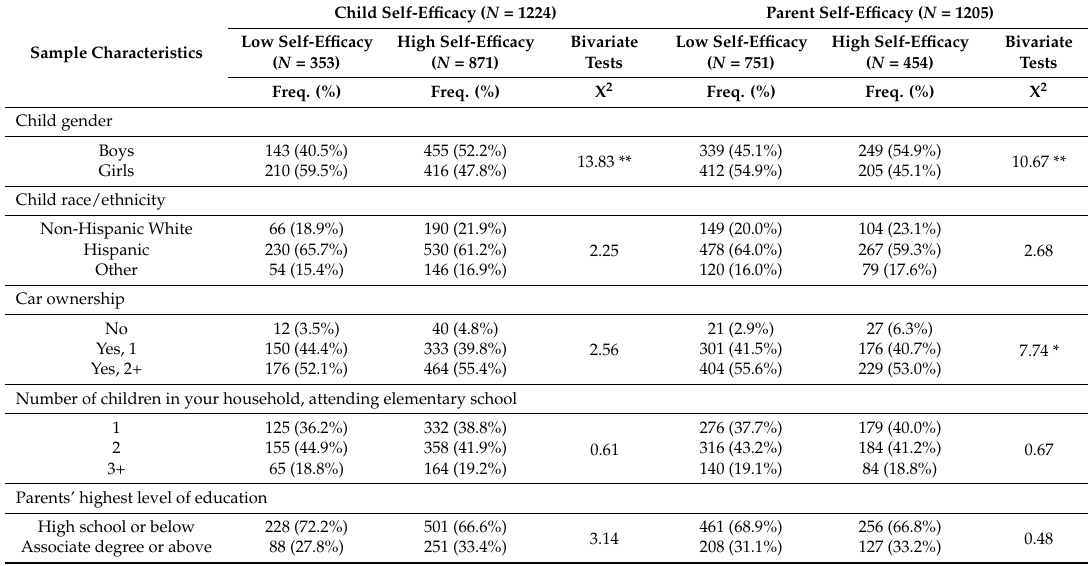
Table 1. Sample characteristics by child and parent self-efficacy and bivariate tests.